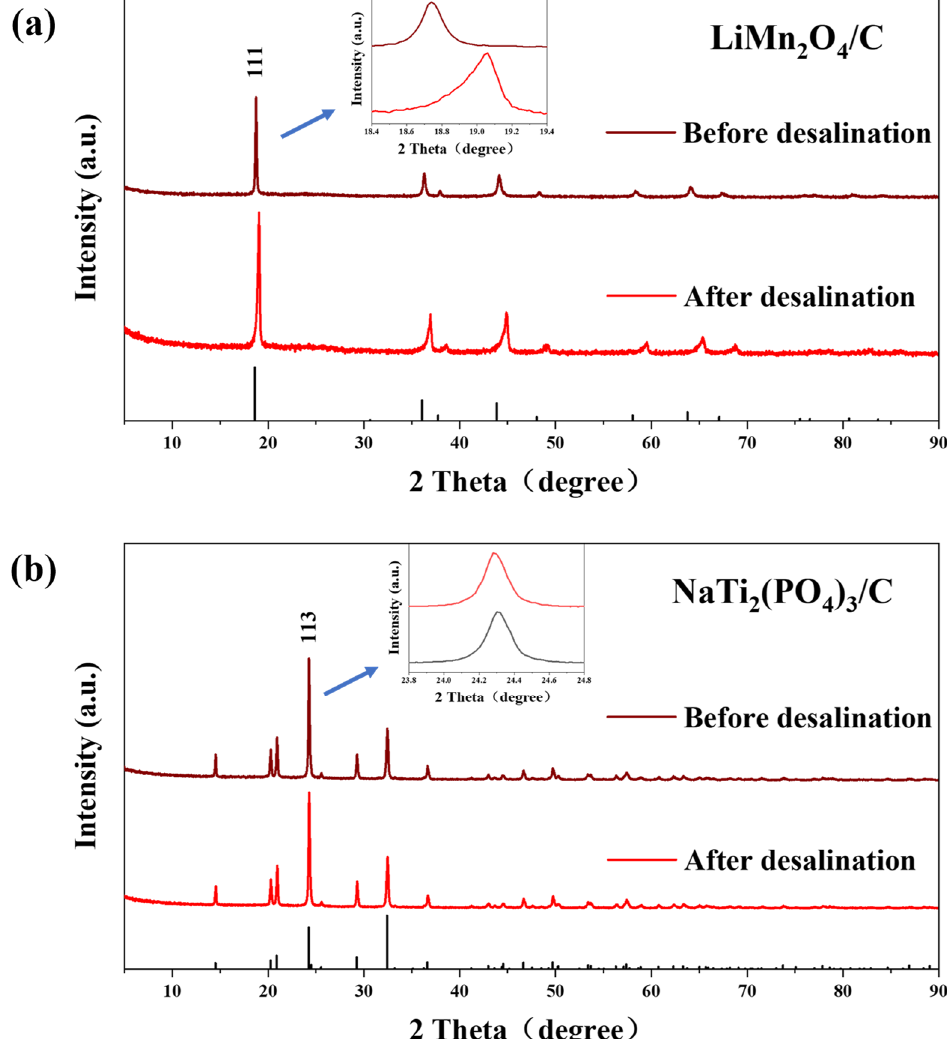
Figure 6. The ( a ) XRD patterns of LiMn 2 O 4 /C and ( b ) NaTi 2 (PO 4 ) 3 /C before and after the desalination test at 1.8 V in 10 mM salt solution.